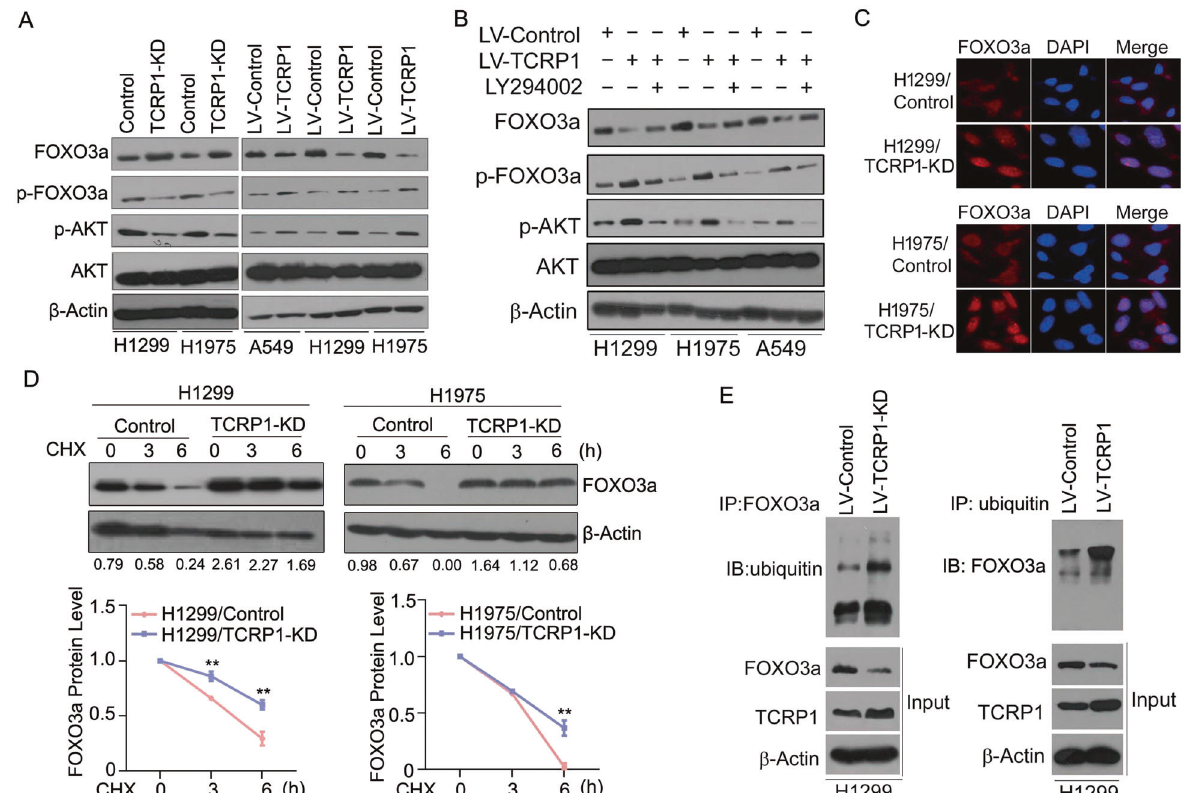
Fig. 6 TCRP1 mediated nuclear location and expression of FOXO3a via AKT. In NSCLC cells with knocking down or increasing TCRP1 ( A ), and in NSCLC cells with overexpression of TCRP1 combing with PI3K inhibitor LY294002 ( B ), western blot assays were performed to measure the phosphorylation levels and protein levels of FOXO3a and AKT. C The nuclear localization of FOXO3a was exhibited via IF assays in H1299 and H1975 cells with decreasing TCRP1. ( D ) TCRP1-knockdown H1299 and H1975 cells were treated with CHX for 0, 3, and 6 h, western blot assays and Image J software were used to determine FOXO3a expression. vs Control, ** P < 0.01. ( E ) CO-IP assays were carried out to test the ubiquitination level of FOXO3a in H1299 cells with enhancing